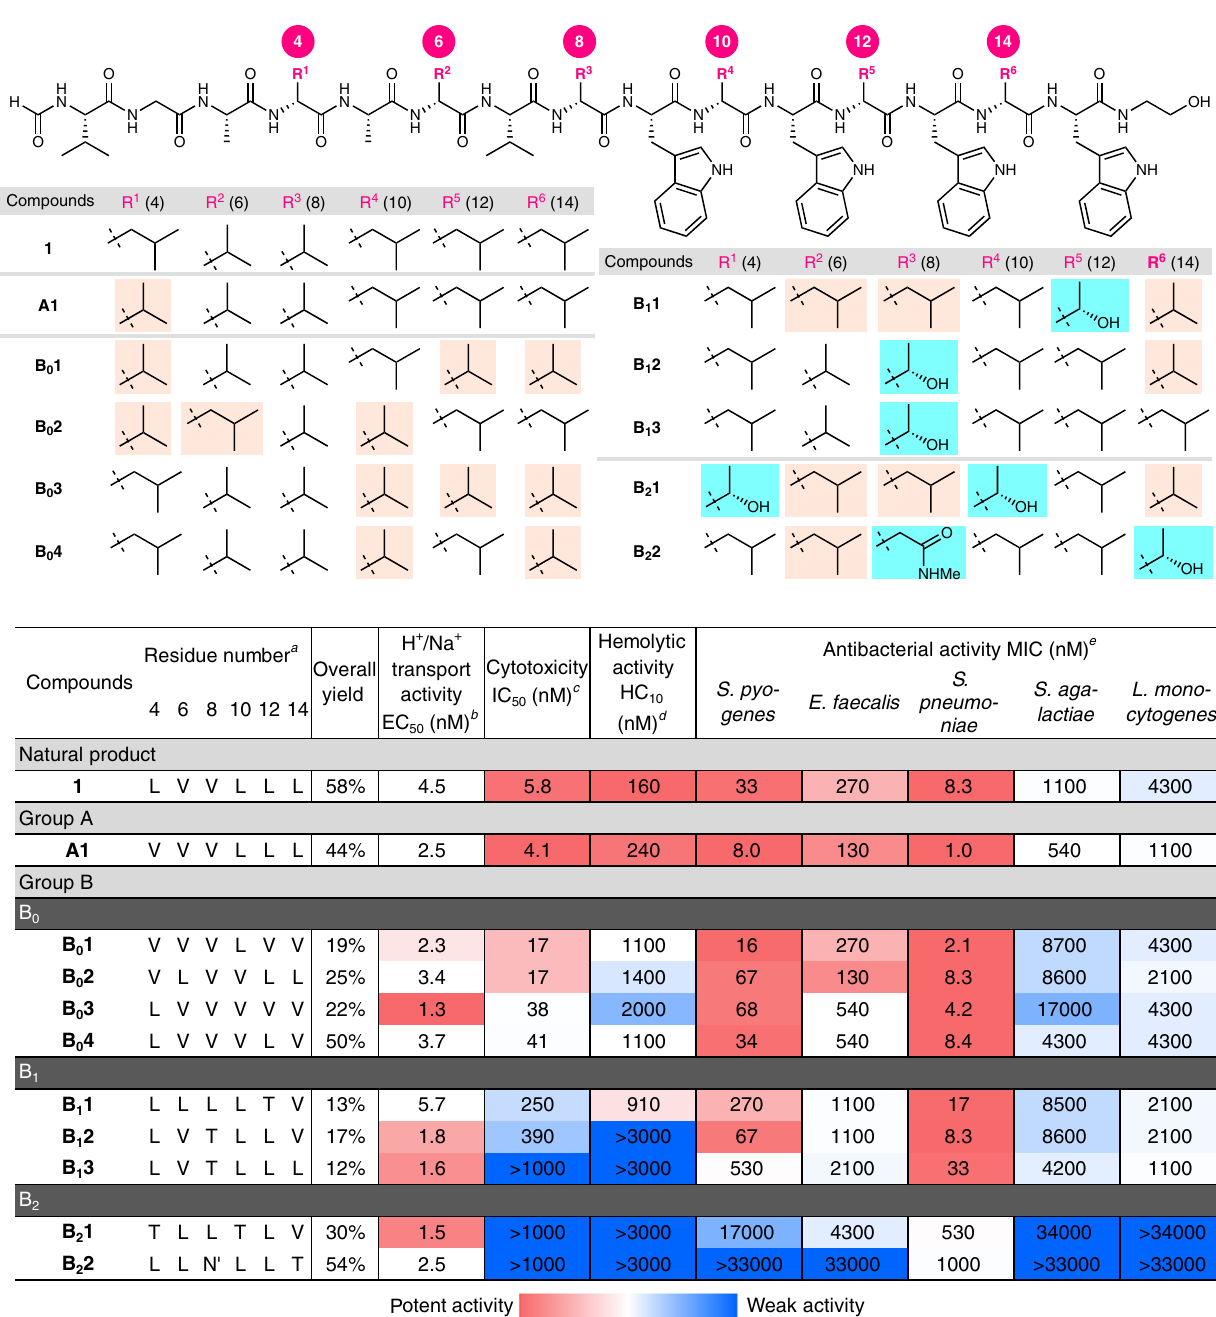
Fig. 4 Structures and four activities of the 10 selected analogues of gramicidin A. a Amino acids are displayed as one-letter codes. b EC 50 value of H + / Na + transport activity toward the pH-gradient large unilamellar vesicles consisting of EYPC and EYPG (19:1). Upper and lower limits of the color gradient are 1000 nM (blue) and 1.3 nM (red), respectively. c IC 50 value against the P388 mouse leukemia cell line. Upper and lower limits of the color gradient are 1000 nM (blue) and 4.1 nM (red), respectively. d HC 10 value against the rabbit red blood cells. Upper and lower limits of the color gradient are 3000 nM (blue) and 160 nM (red), respectively. e MIC values (nM) were determined by the microdilution method. Upper and lower limits of the color gradient are 33,000 nM (blue) and 8.0 nM (red),